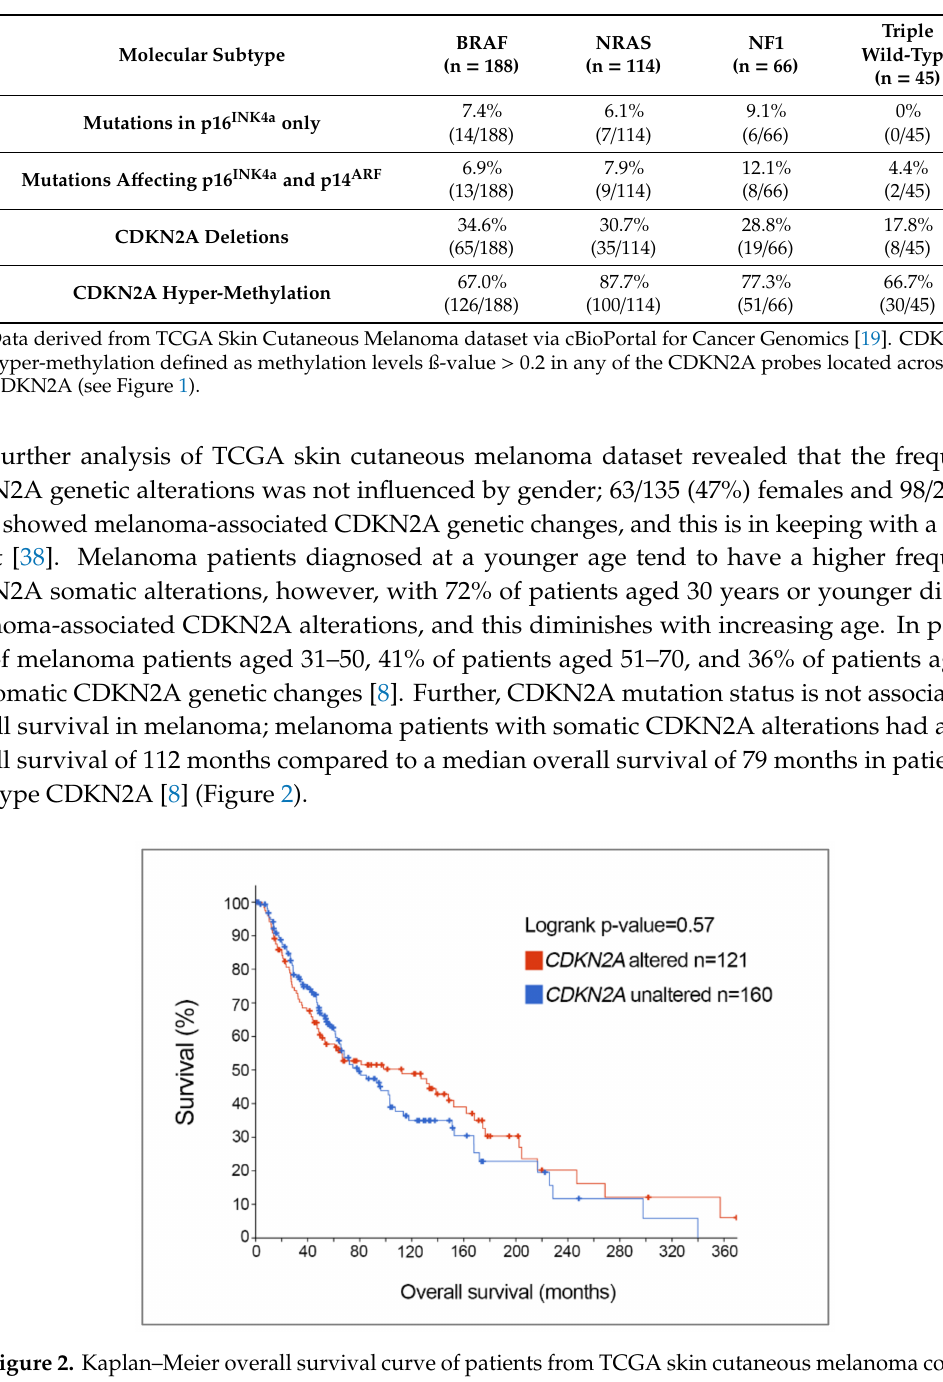
Table 1. Frequency and type of CDKN2A alterations in the four cutaneous melanoma genomic subtypes, designated BRAF, RAS, NF1, and triple wild-type.